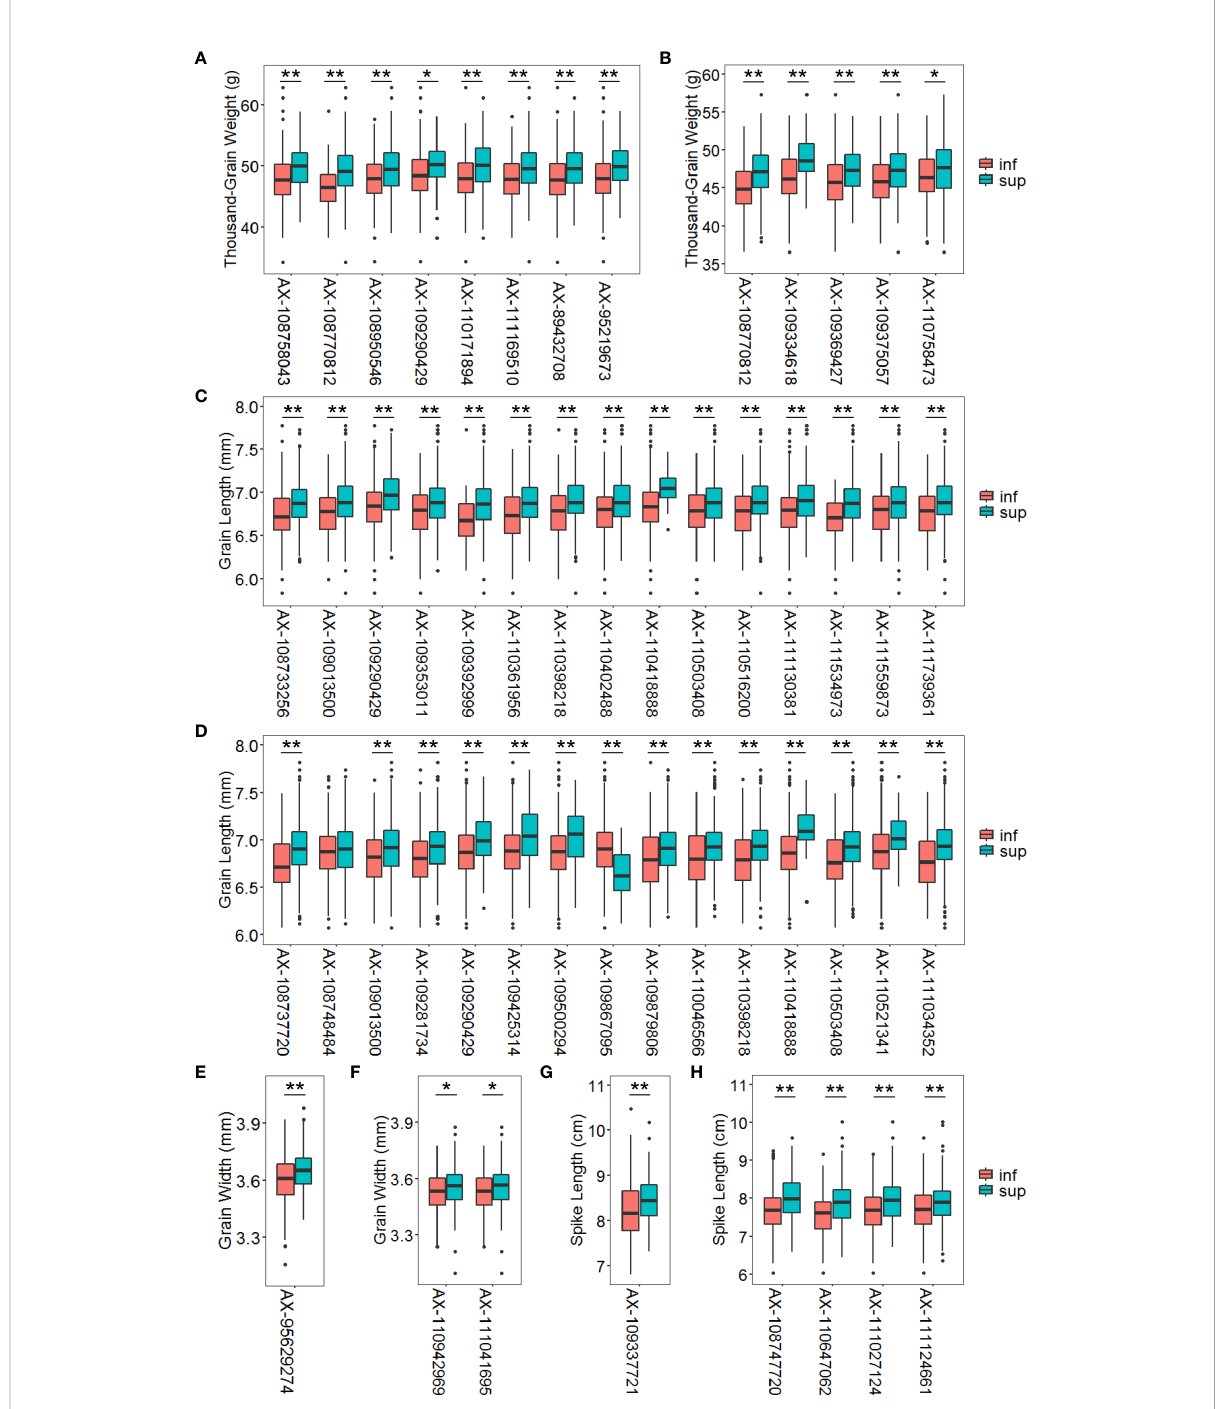
FIGURE 6 Average phenotypic values of accessions with different alleles in multi-environment signi fi cant loci under normal and drought treatment conditions for thousand-grain weight (A, B) , grain length (C, D) , grain width (E, F) and spike length (G, H) . The P value was determined by the two tailed Student ’ s t -test. * P < 0.05, ** P < 0.01. Inf represents the inferior allele and sup represents the superior